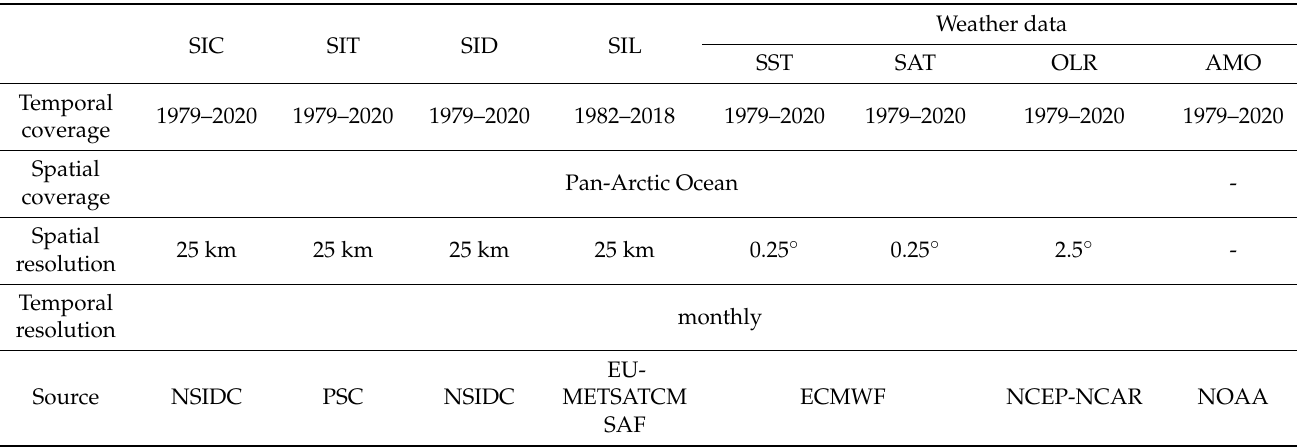
Table 1. Temporal and spatial coverages of remote sensing data and atmospheric, oceanic parameters that are used in this